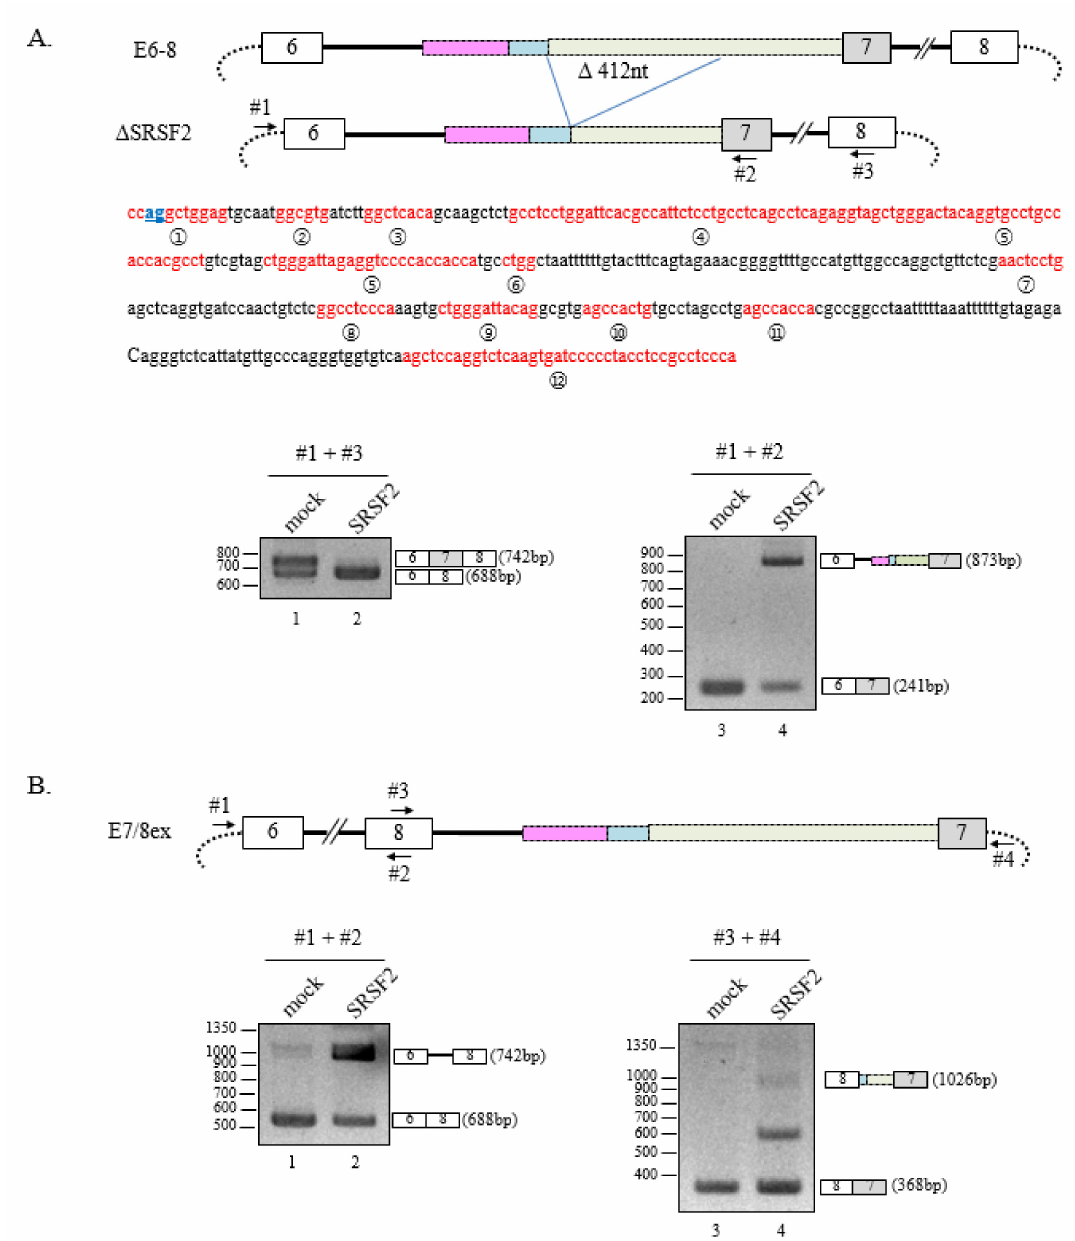
Figure 3. Multi SRSF2-binding sequences and clusters are responsible for 3 (cid:48) AG (cid:48) activation by SRSF2. ( A ) (Upper panel) Schematic diagram of the ∆ SRSF2 minigene. The nucleotide deletion is indicated using blue lines. The primer binding sites used in lower panels are indicated with arrows. (Middle panel) The sequence of deleted 412 nt is shown. Potential SRSF2 binding sites and clusters are shown in red and numbered. (Lower panel) RT-PCR analysis of the ∆ SRSF2 minigene in SRSF2-expressing cells using primers #1 and #3 (left) or #1 and #2 (right). ( B ) (Upper panel) Schematic diagram of the E7 / 8ex minigene where a portion including intron 6 though exon 7 was swapped with a region containing intron 7 through exon 8. The primer binding sites used in lower panels are indicated with arrows. (Lower panel) RT-PCR analysis of the E7 / 8ex minigene in SRSF2-expressing cells using primers #1 and #2 (left) or #3 and #4